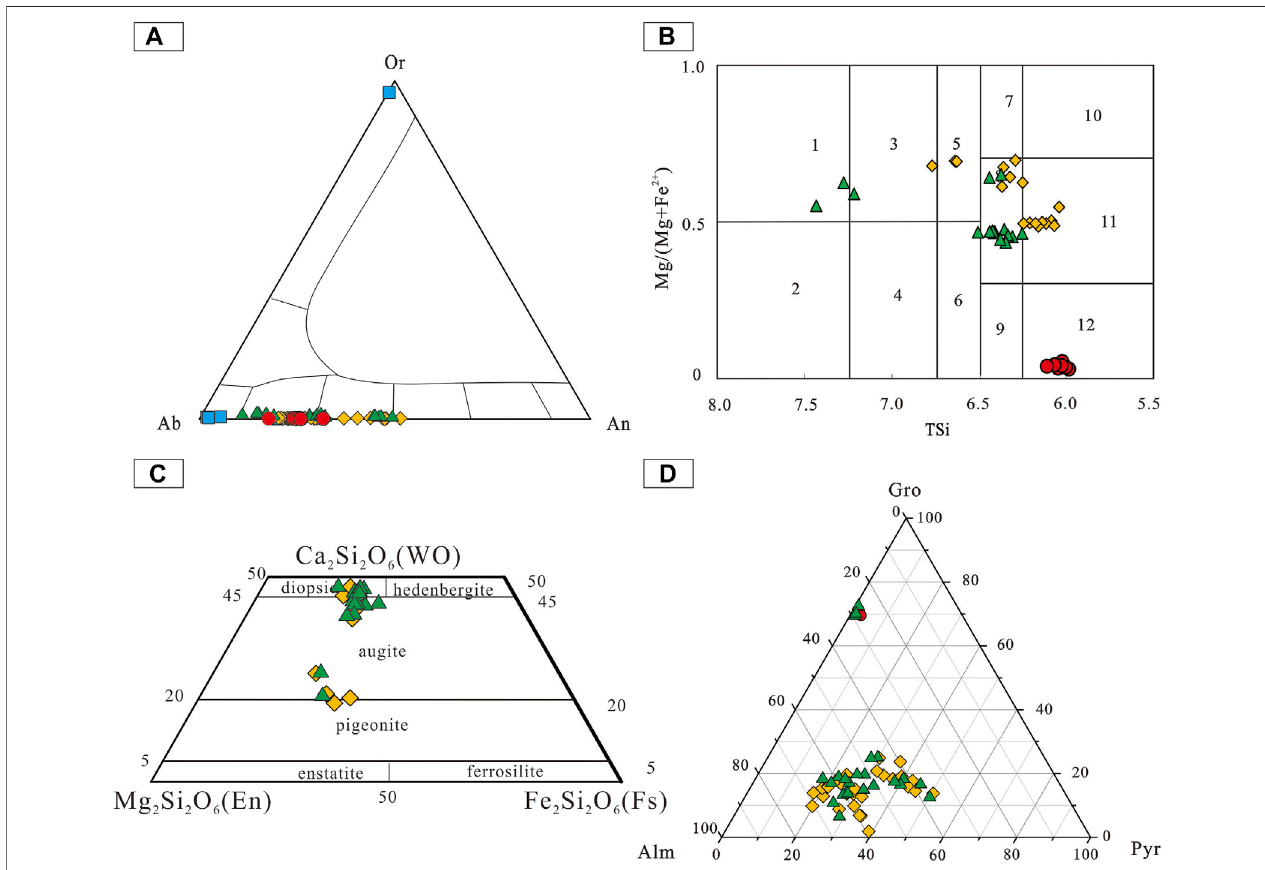
FIGURE 8 | Or-Ab-An classi fi cation map of plagioclase (A) , classi fi cation map of amphibole after Leake et al. (1997) (B) , classi fi cation map of clinopyroxene after Morimoto (1988) (C) , and Alm-Pyr-Gro classi fi cation map of garnet (D) . These minerals are mentioned in Figure 7 .